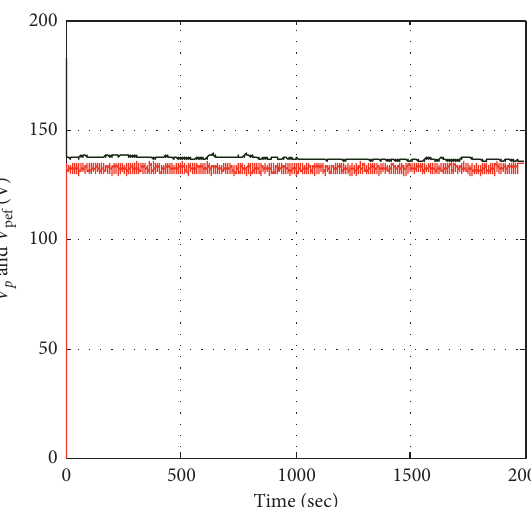
Figure 20: Evolution of real and optimal voltages of